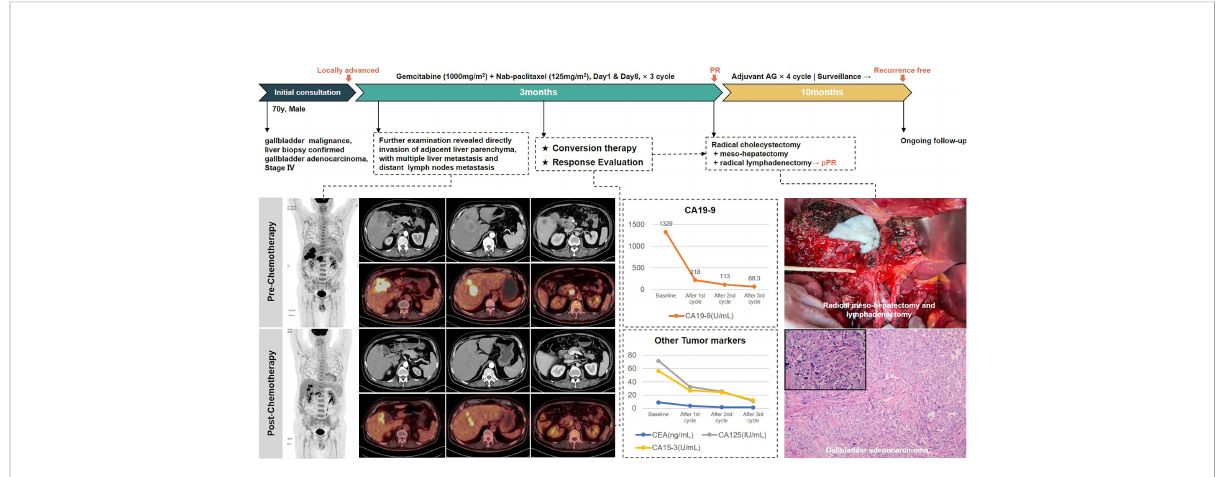
FIGURE 5 The treatment process of patient